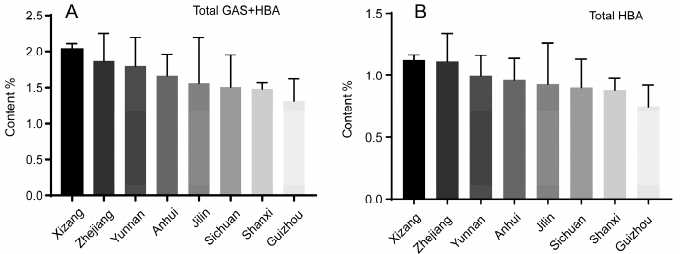
Figure 4. The content of components of G. elata after hydrolysis: ( A ) the sum of total GAS and HBA in G. elata after base hydrolysis; ( B ) total HBA in G. elata after base-enzymatic hydrolysis. Data, expressed as percentage of crude drug, were the mean ± SD of different batches, and each batch at three experiments.